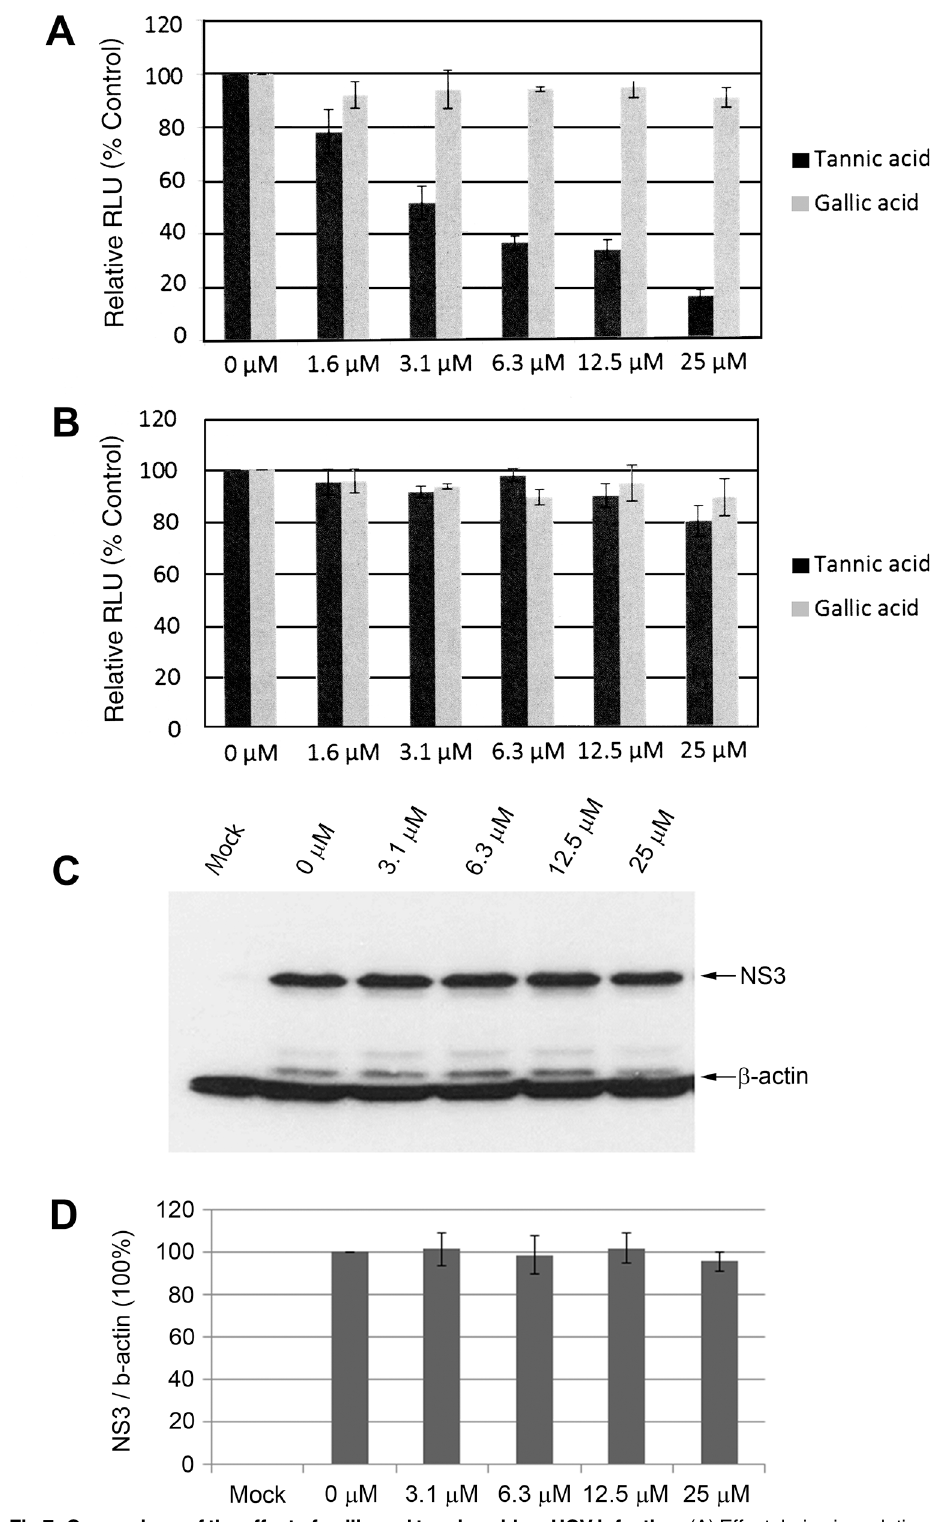
Fig 7. Comparison of the effect of gallic and tannic acid on HCV infection. (A) Effect during inoculation in an HCV cell culture system. Huh7.5 cells were infected with JFH1-AM120-Rluc for two hours in the presence of the specified concentrations of gallic or tannic acid, cells were washed and further incubated for 48 hours